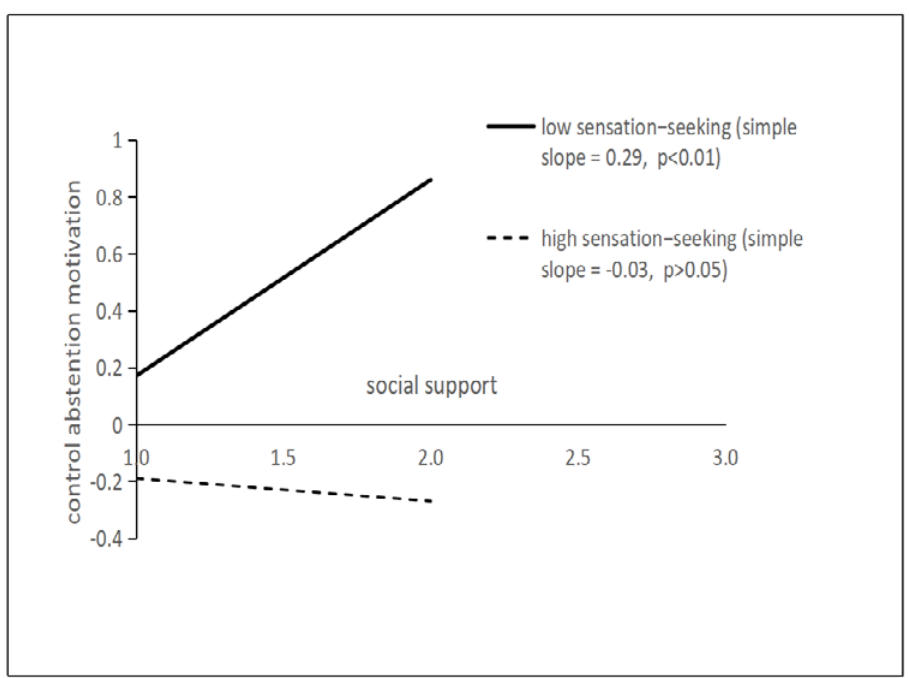
Figure 3. The moderating effect of sensation-seeking on the effect of social support on control abstention motivation.